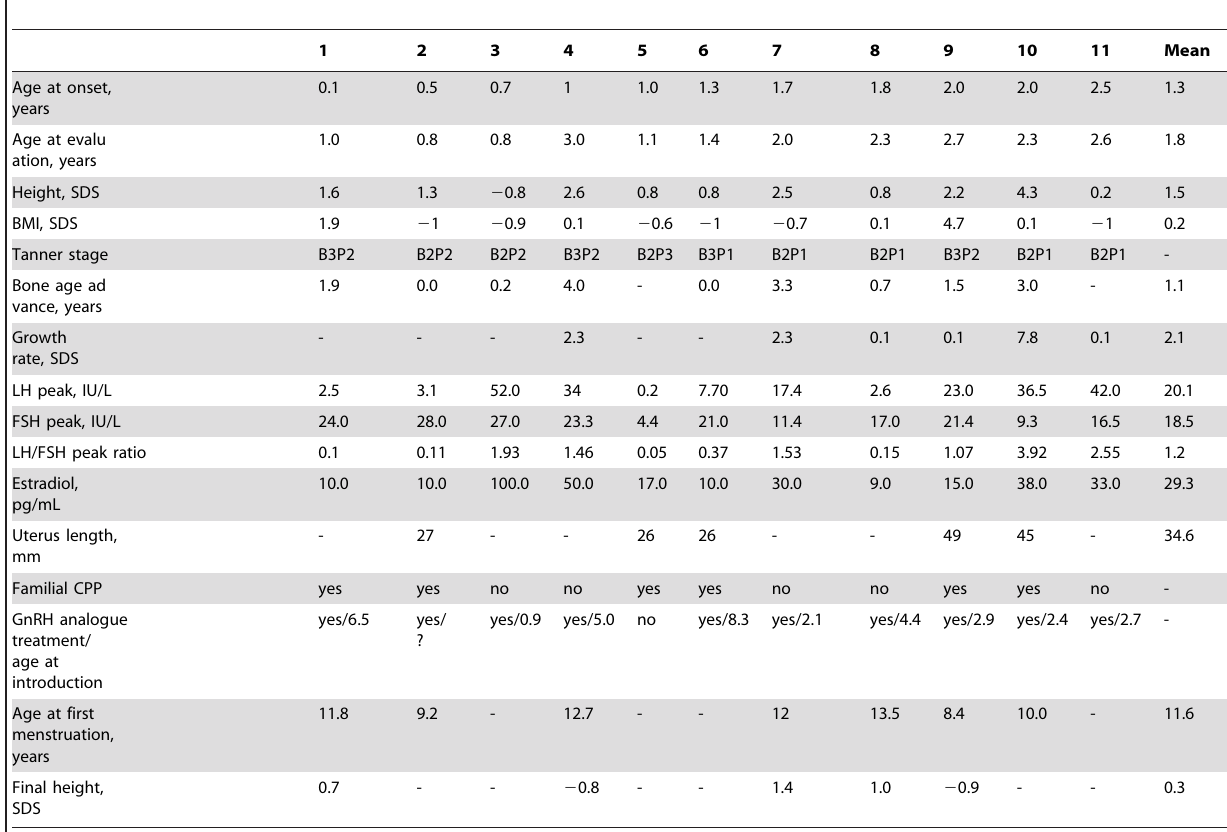
Table 2. Characteristics of 11 girls who began idiopathic CPP before 3